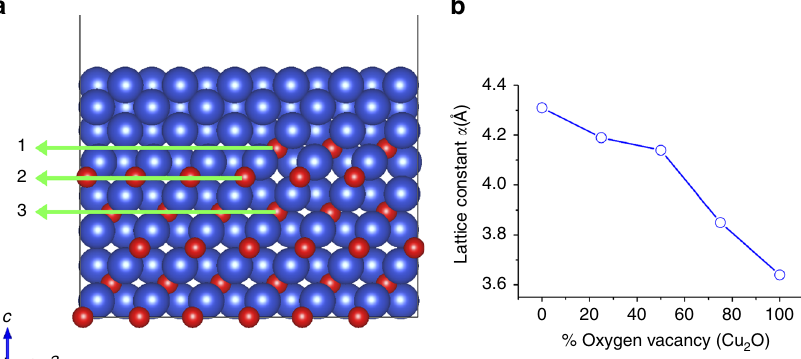
Fig. 5 DFT calculations a Oxygen vacancy formation energy ( E vac ) for three representative interfacial sites, 1: interface step, 2: planar interface, 3: sub-interface. b Lattice constant as a function of the concentration of oxygen vacancies in Cu 2 O. Blue and red spheres represent Cu and O atoms,